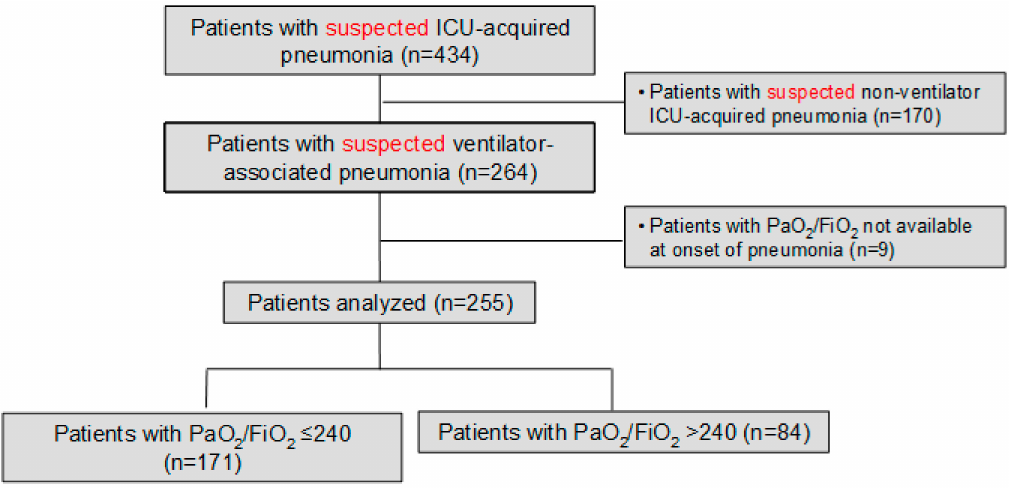
Figure 1. Flow chart of the study population.